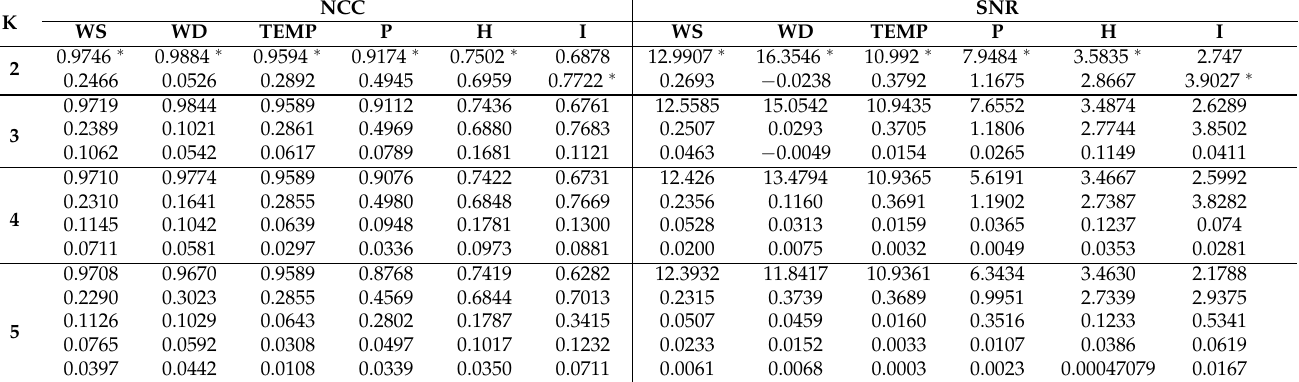
Table 2. NCC and SNR of each environment variable component at different K